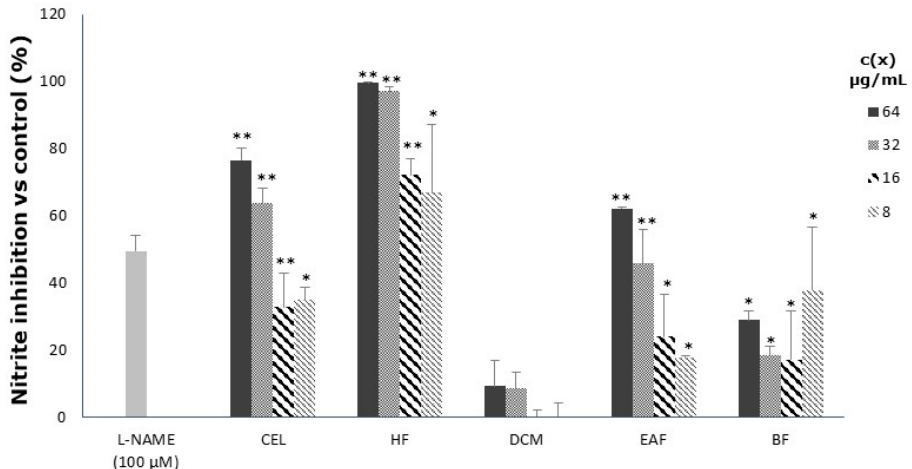
Figure 2. Effect of crude extract (CEL), n-hexane fraction (HF), dichloromethane fraction (DCM), ethyl acetate fraction (EAF) and n-butanol fraction (BF) on nitric oxide production in LPS-stimulated RAW 264.7 macrophages. The extracellular nitrite accumulation was measured by the Griess reaction. * and ** mean significant statistical differences with the untreated group at ( p < 0.05) and ( p < 0.01), respectively, according to a Mann–Whitney test.